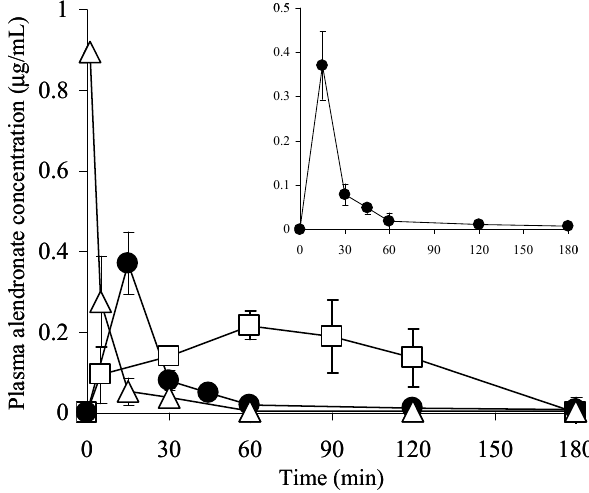
Figure 5. Plasma concentrations of ALN after various administration methods. Results are expressed as the mean ± S.E. of three mice. ● , ALN(TIP)–MN (1.5 mg ALN/kg); △ , i.v. (1 mg ALN/kg); □ , p.o. (50 mg ALN/kg). i.v.; intravenous injection, p.o.; oral administration. Table 1. Pharmacokinetic parameters of ALN (alendronate) after various administration methods. C max: maximum plasma concentration, T max : time to maximum plasma concentration, AUC: area under the plasma concentration-time curve, BA: bioavailability, i.v.: intravenous injection, p.o.: oral administration.